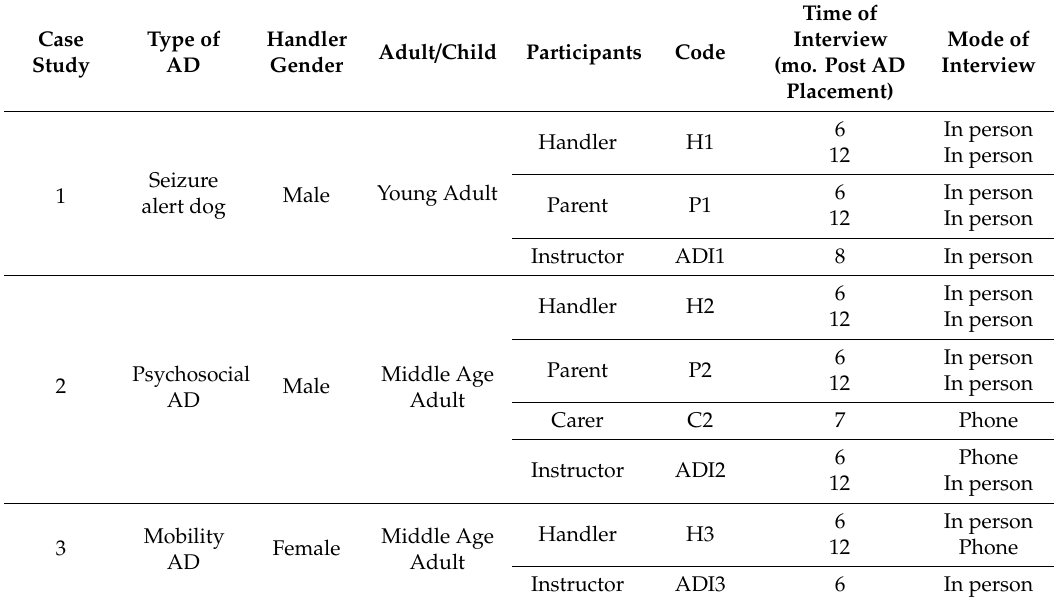
Table 1. Demographic information for case study